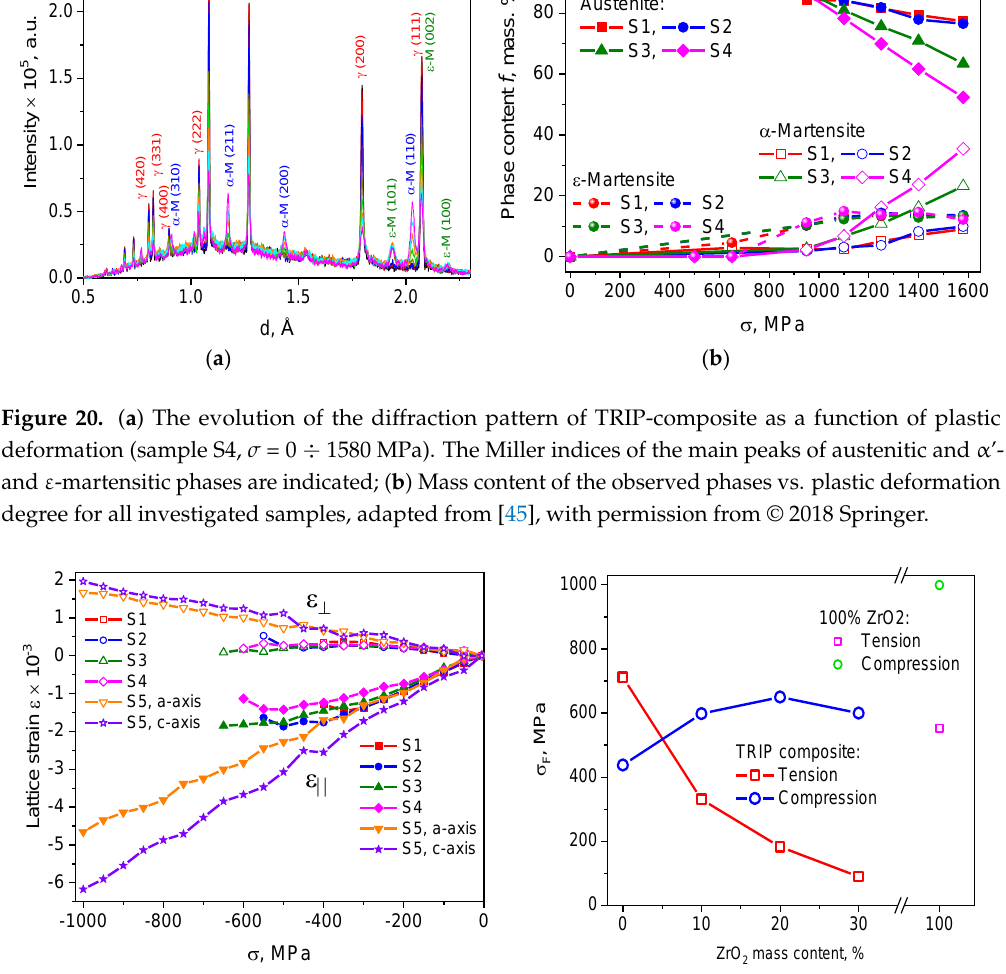
TRIP composite: Tension